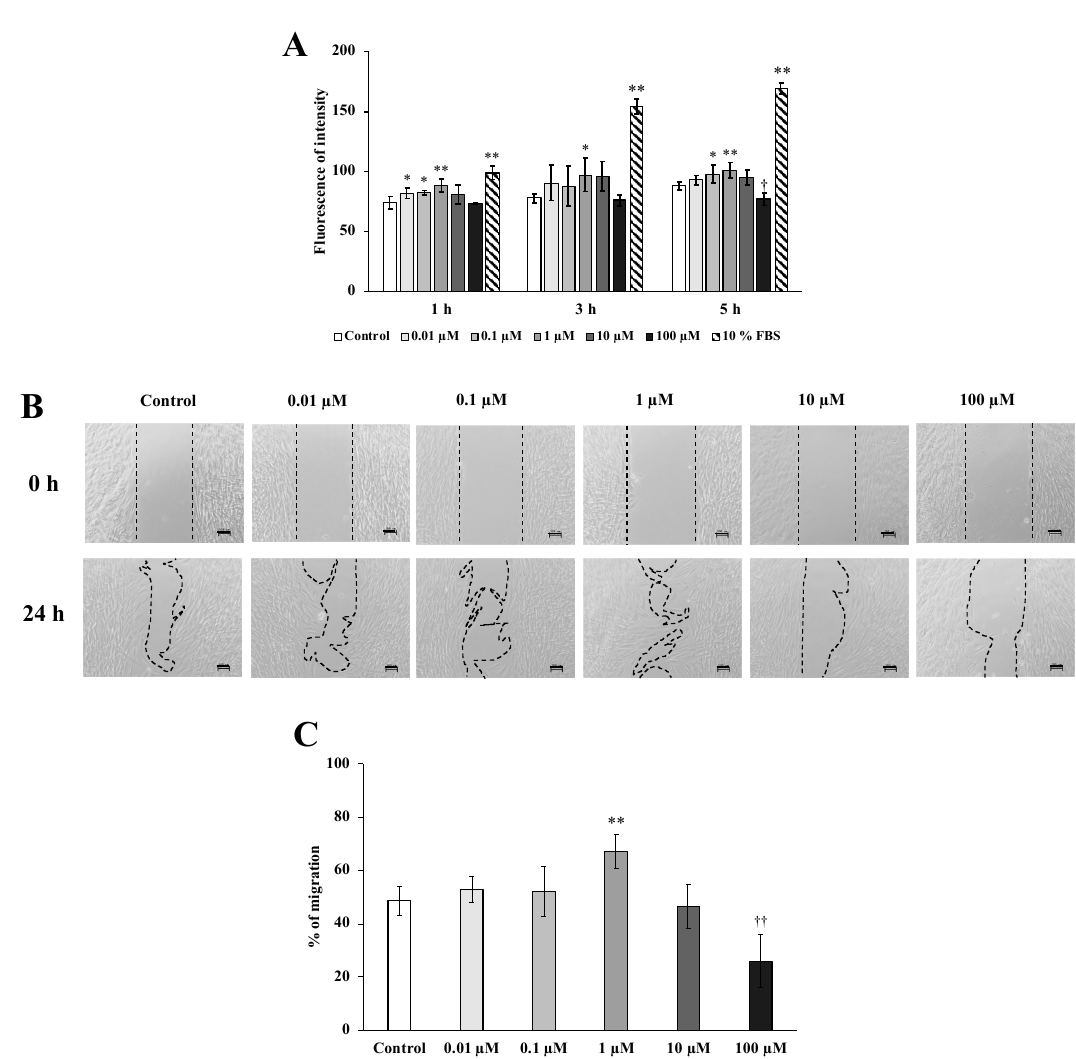
Figure 2. Effect of shikonin on human gingival fibroblast (hGF) migration and wound repair. ( A ) hGF migration in response to control or shikonin treatment (0.01, 0.1, 1, 10, or 100 µ M) (* p < 0.05 at 1, 3, and 5 h vs. control; ** p < 0.01 at 1, 3, and 5 h vs. control; † p < 0.05 at 1, 3, and 5 h vs. control). Fetal bovine serum (10%) was used as the positive control. ( B ) Wound healing was measured after 0 and 24 h (Scale bar = 100 µ m). ( C ) The change in the wound area is presented as the ratio of the final to the initial wound size (** p < 0.01 vs. control; †† p < 0.01 vs. control).